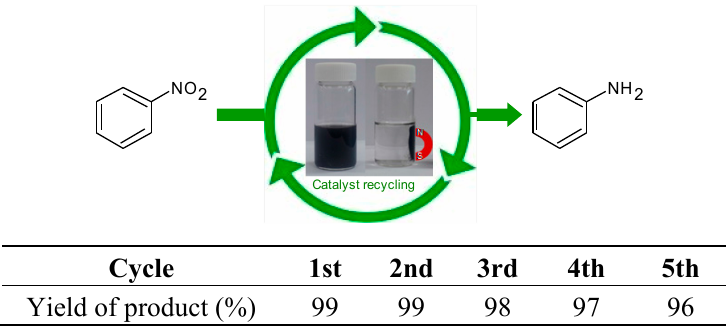
Table 3. Magnetic separation and recycling of the Pt nanocomposite catalyst in the heterogeneous reduction of nitrobenzene with hydrazine under the optimized reaction conditions. Reprinted with permission from